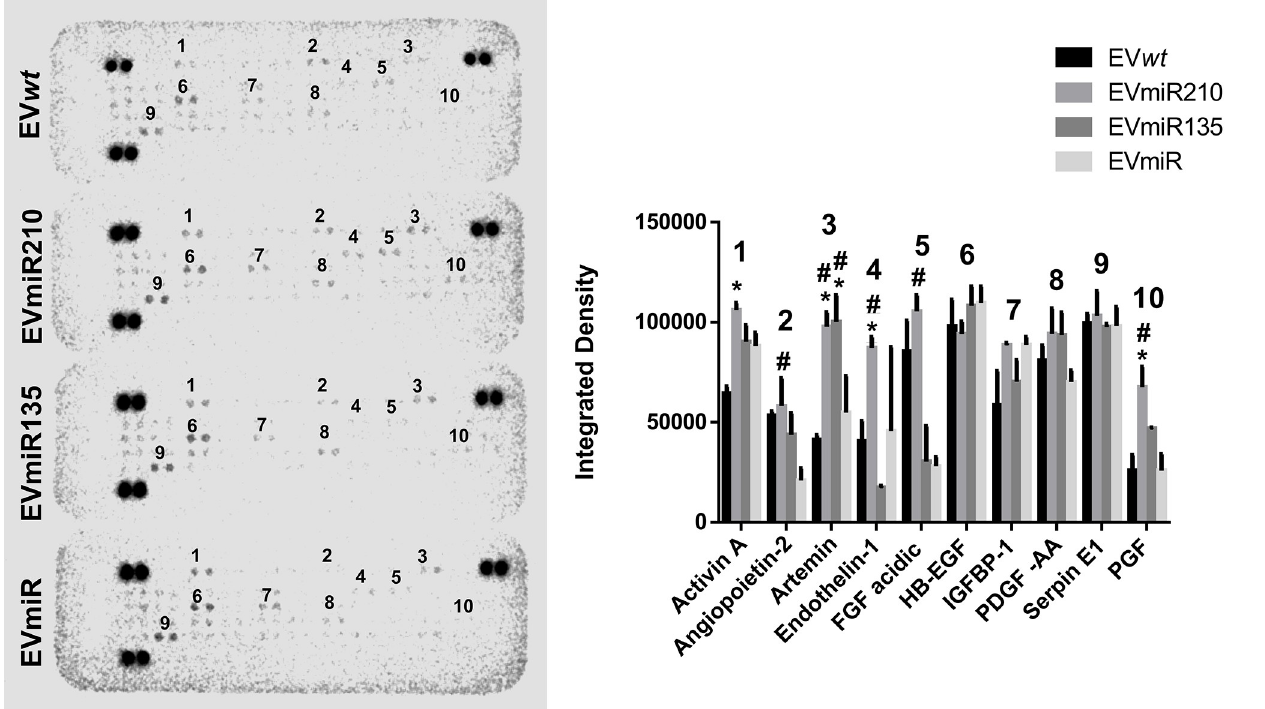
Fig 6. Profile of angiogenic-related proteins in HUVECs after treatment with EVmiRs. The membrane was exposed for 8 min in a bioluminescence detector (left), and the intensity of each spot was measured using ImageJ software (right). The significance of the differences was analyzed by two-way ANOVA and Bonferroni correction for the post hoc analysis. � indicates p < 0.05 in comparison with EV wt s; # indicates p < 0.05 in comparison with EVmiRs. EV wt s = MSCwt-derived EVs; EVmiRs = MSCmiR-derived EVs; EVmiR210s = MSCmiR210-derived EVs; EVmiR135bs = MSCmiR135b-derived EVs.